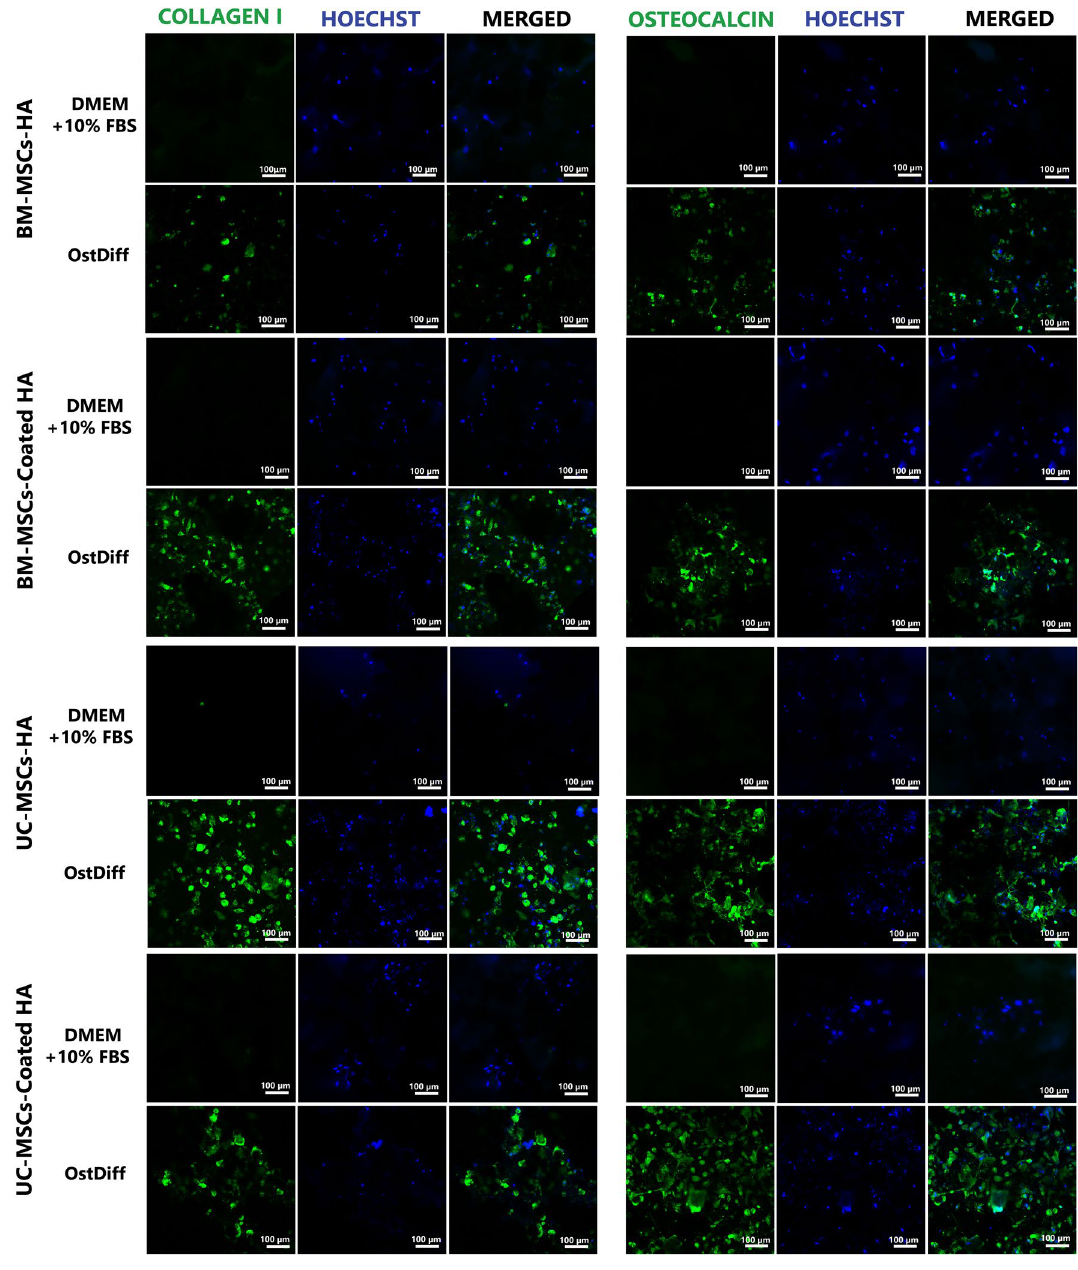
Figure 9. Immunofluorescent micrograph illustrated the expression of osteocalcin and collagen I in BM-MSCs and UC-MSCs cultured on the 3D-printed HA (HA) and coated 3D-printed HA (coated HA) for 21